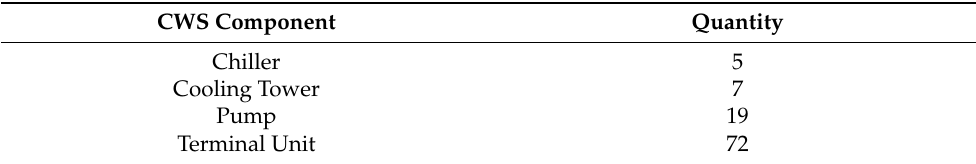
Table 5. Number of CWS Components.